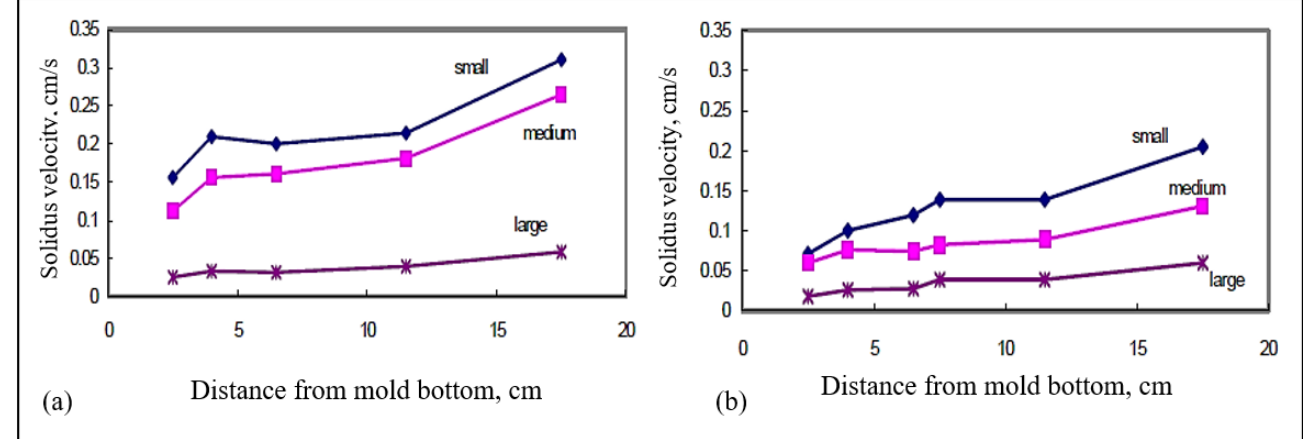
Figure 17. Average vertical solidus interface velocities in the wedge mold as a function of the distance from the bottom of the mold for ( a ) B alloy, ( b ) BB2 alloy (B + 2186 ppm Bi) for small, medium, and large molds.